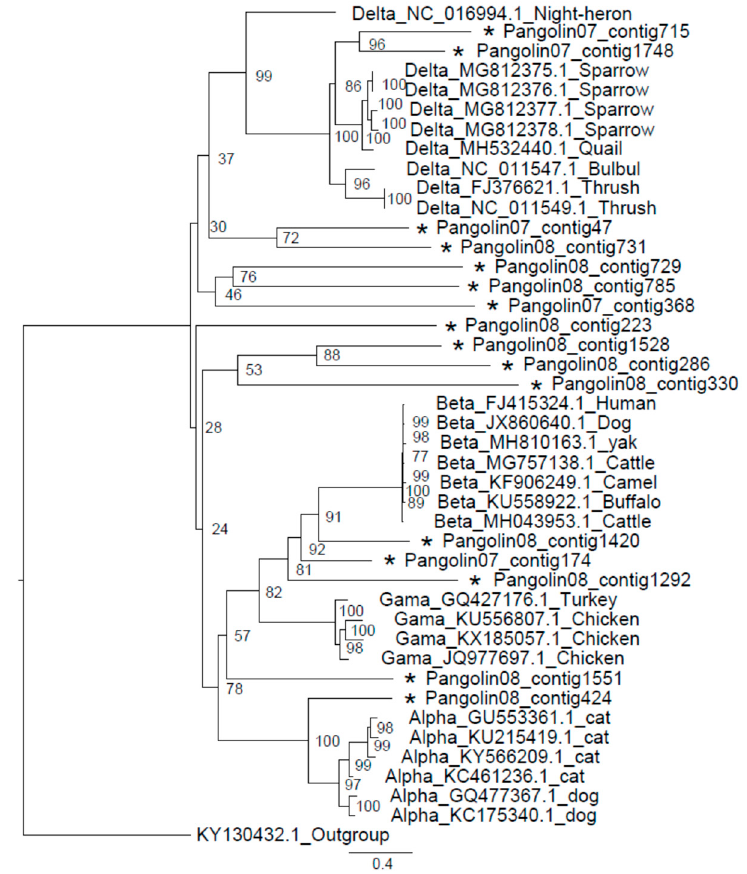
Figure 5. The phylogenetic tree of Conronavirus from Malayan pangolin and other hosts. The analysis was inferred using the Maximum Likelihood method based on iqtree [24]. Branch bootstrap values are shown and were based on 1000 replicates. The black star indicates a contig of the Sendai virus from M. javanica in 2019.